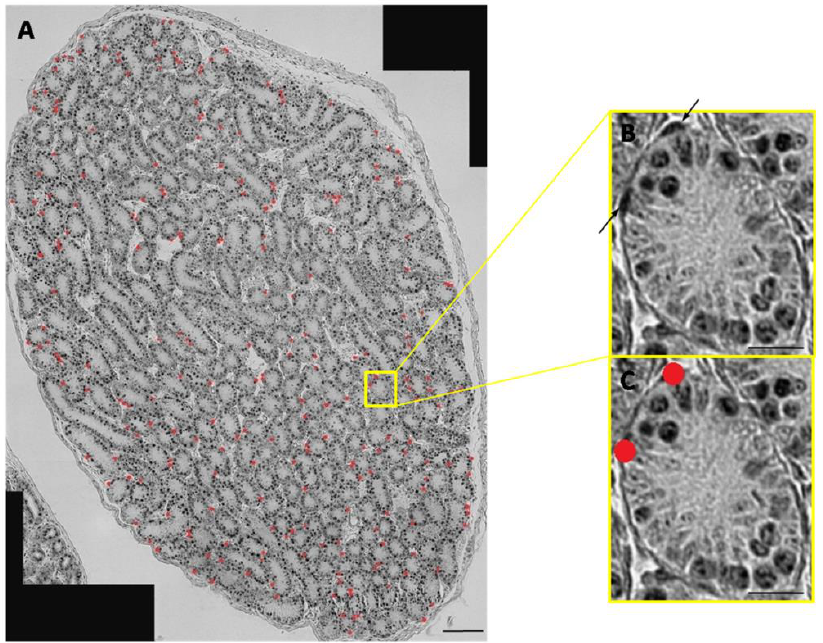
Figure 6. Visualization of proliferating peritubular cells in postnatal murine testis. Testicular tissue sections of wild-type mice were stained with a mAb against PCNA to determine the proliferating status of peritubular cells. ( A ) PCNA-positive peritubular cells are labeled with red dots in the cross section. Additionally, in an enlarged tubule, the same PCNA positive peritubular cells are labeled with ( B ) arrows or ( C ) red dots to illustrate the selection of positive cells. The PCNA-positive cells within the tubules were not considered in the study. Scale bars: ( A ) 100 µm; ( B,C ) 20 μm. Negative controls are provided in Supplemental Figure S1.